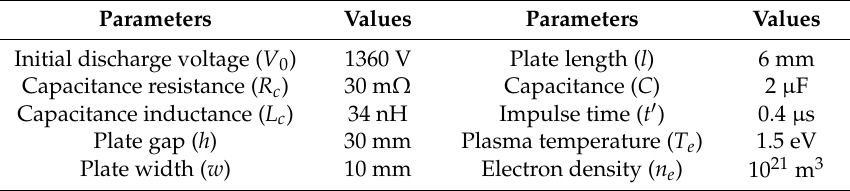
Table 3. Operation parameters of Lincoln Experimental Satellite 6 (LES-6) PPT